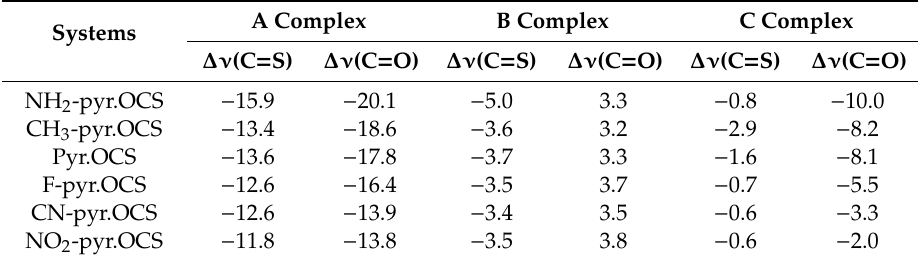
Table 10. Shifts of the ν (C = S) and ν (C = O) vibrations (cm − 1 ) in the A , B , and C complexes of pyridines with